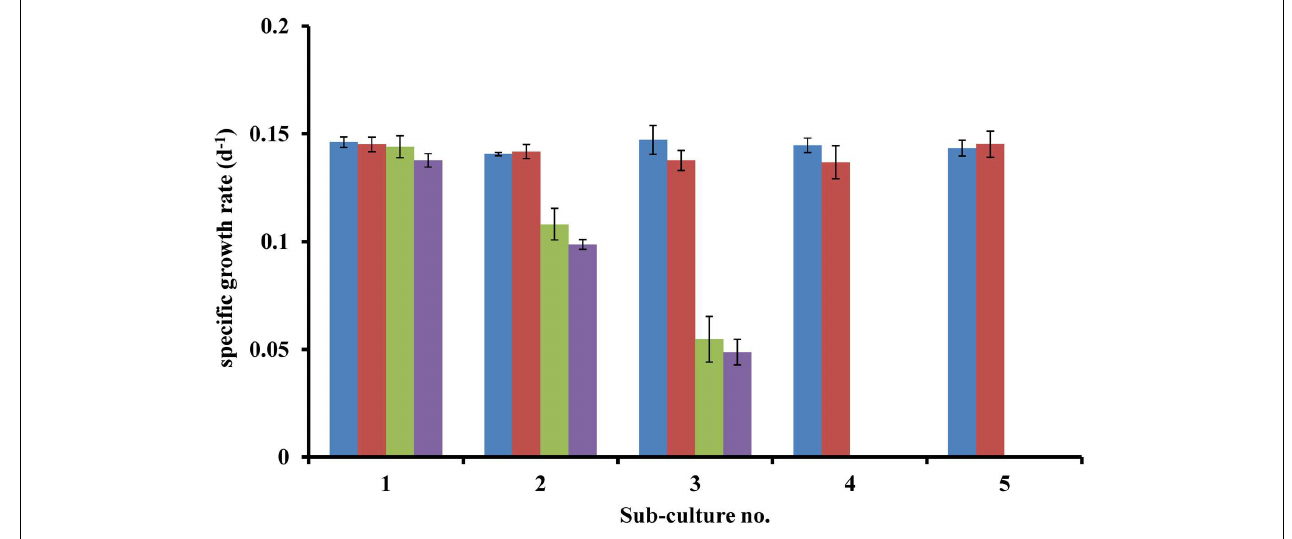
FIGURE 1 | Specific growth rates of axenic L. polyedrum grown in: ( (cid:4) ) B 1 B 7 B 12 -s; ( (cid:4) ) B 1 B 12 -s; ( (cid:4) ) B 1 B 7 -s; ( (cid:4) ) B 7 B 12 -s